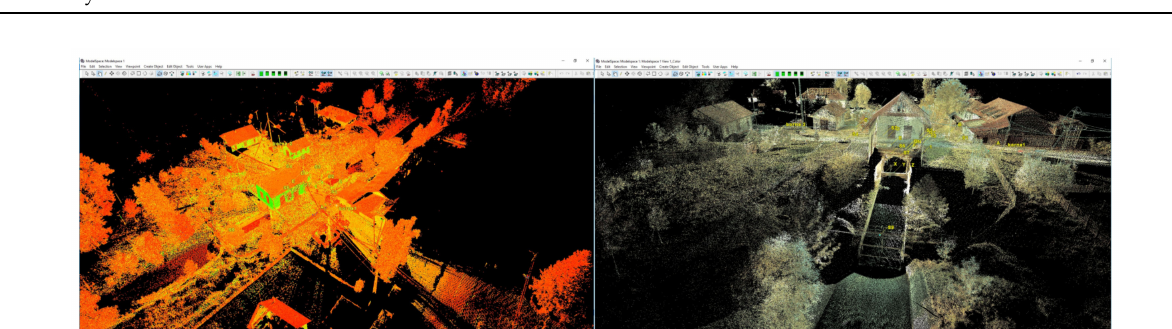
Figure 16. Point Cloud-NH Cos